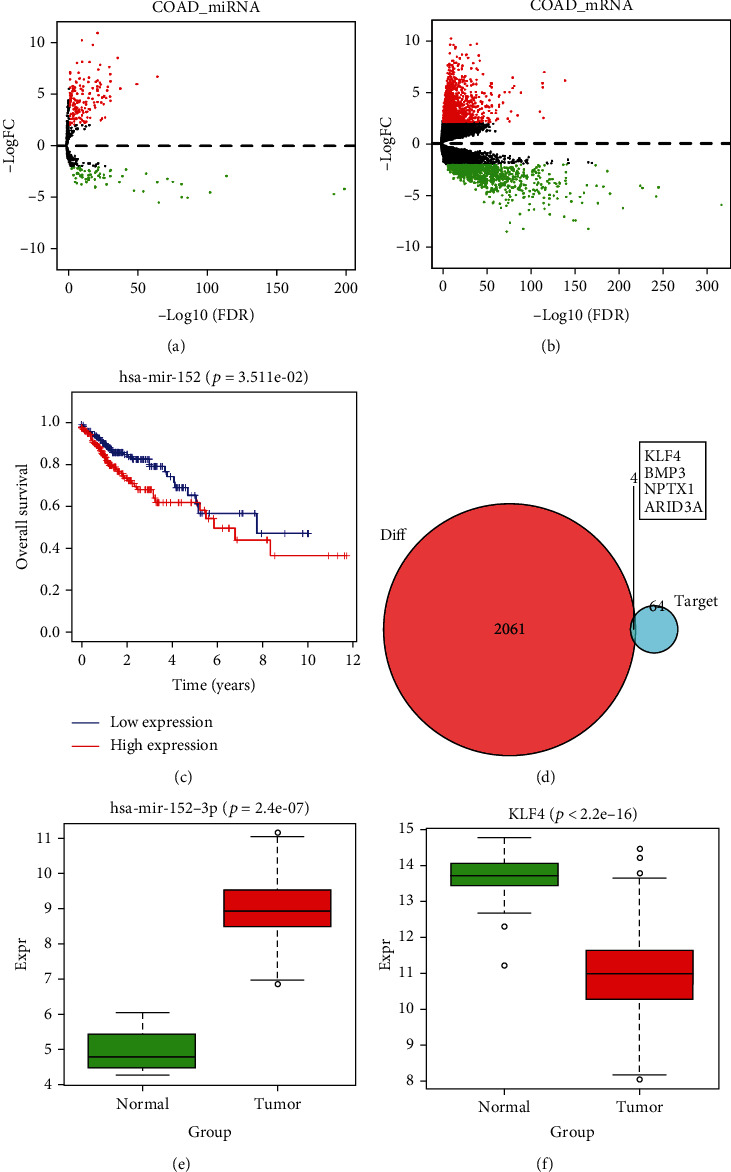
Bioinformatics analysis. Volcano plots were made to find the (a) DEmiRNAs and (b) DEmRNAs in TCGA-COAD dataset. (c) Survival analysis was performed, and it was found that miR-152-3p was of remarkable survival significance. (d) Venn diagram was plotted to find the candidate target genes from the predicted mRNAs of miR-152-3p and the DEmRNAs in TCGA-COAD dataset. (e) miR-152-3p was shown to be significantly upregulated in the colon cancer tissue in TCGA-COAD dataset. (f) KLF4 was verified to be noticeably lowly expressed in cancer tissue in TCGA-COAD dataset.